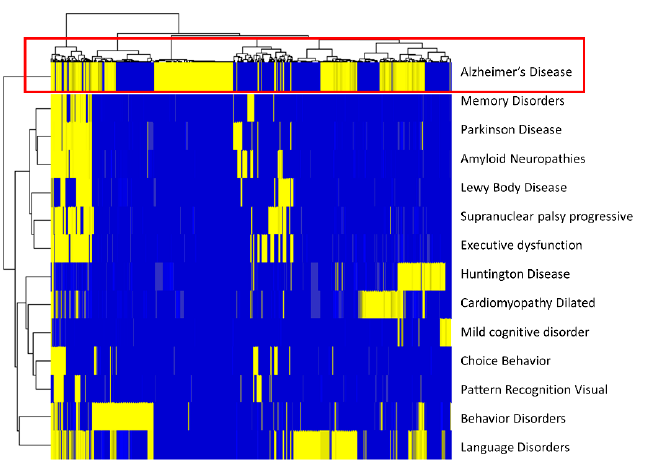
Figure A1 . Dendrogram and heatmap of the drug-disease network. The network adjusted similarity values are clustered according to rows (diseases) and columns (drugs) by using Ward's minimum variance method as linkage hierarchical clustering algorithm and by using the Euclidean distance as distance metric. Heatmap color key denotes the adjusted and normalized network similarity between drug targets and disease genes in the human interactome, increasing from blue (less similar) to red (more similar).